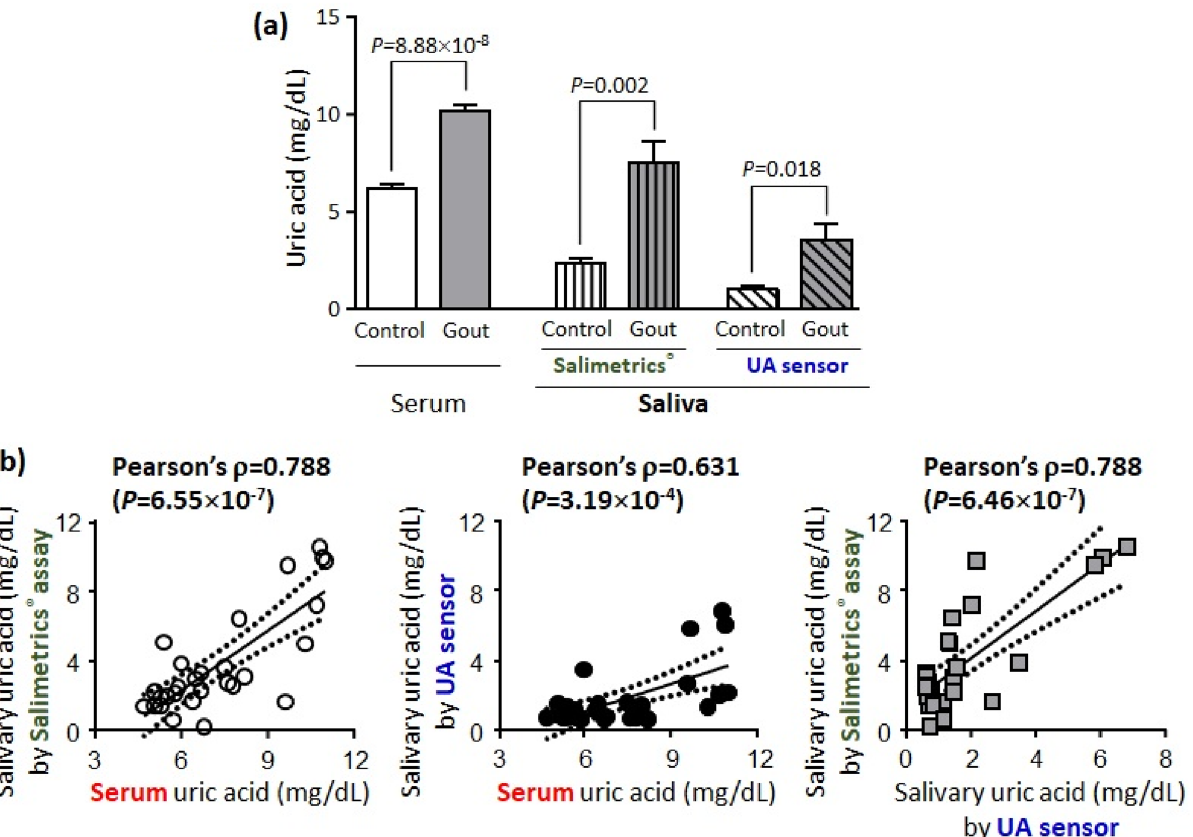
Figure 4. Uric acid (UA) levels in serum and unstimulated whole saliva samples. ( a ) Patients with gout (n = 8) showed significantly higher levels of serum or salivary UA than control subjects (n = 20, all p < 0.05). Salivary UA levels measured with our UA sensor were significantly lower than serum and salivary UA levels measured via conventional enzymatic colorimetric assays in both controls and gout cases (both p < 0.0001 by ANOVA). Error bars represent standard error of mean. ( b ) UA levels in serum or saliva (measured with Salimetrics® and UA sensor) were significantly positively correlated with each